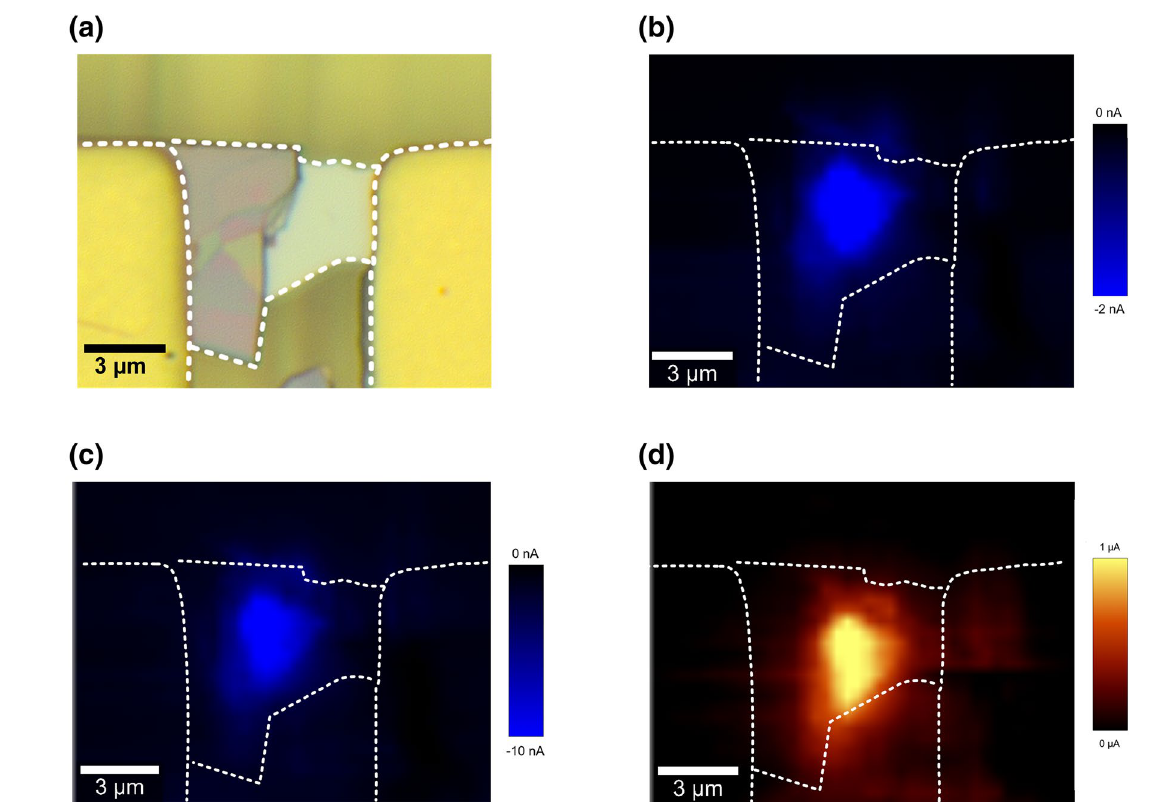
Fig. 3 Optical scanning photocurrent images of the α-In 2 Se 3 /3R MoS 2 heterojunction. a The optical image. b – d Photocurrent mapping of the heterojunction under zero bias, reverse bias of − 0.25 V and forward bias of 0.25 V at 532 nm with a laser power of 0.1 mW and a spot waist radius of 400